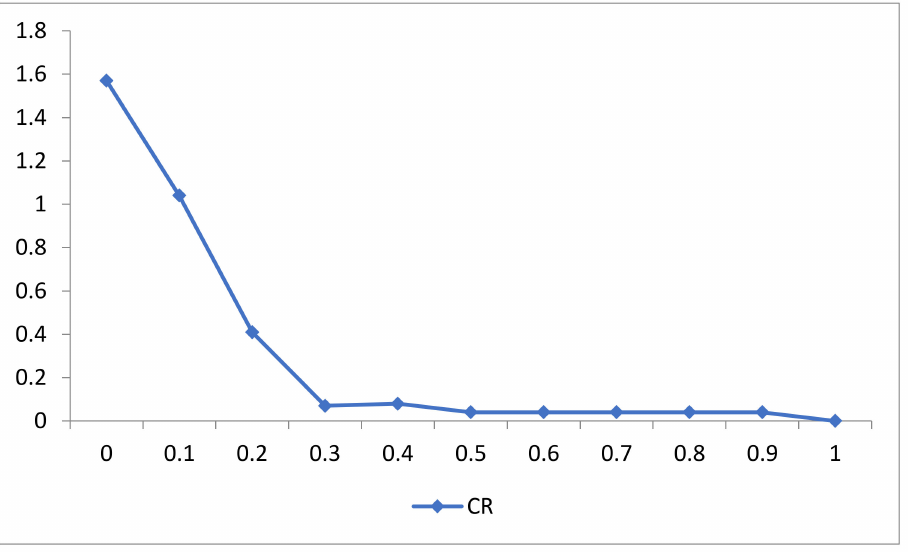
Figure 3. CR over µ